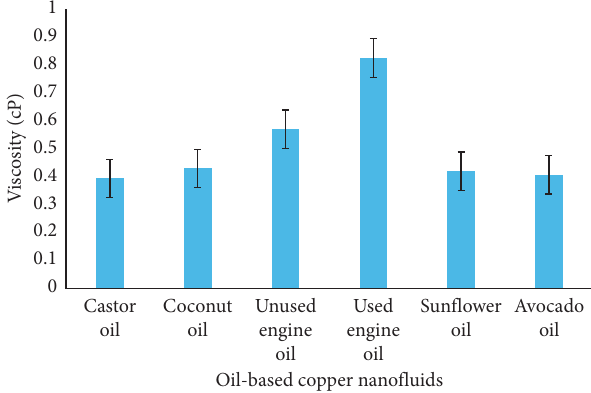
Figure 1: Viscosity of oil-based copper nano-heat transfer